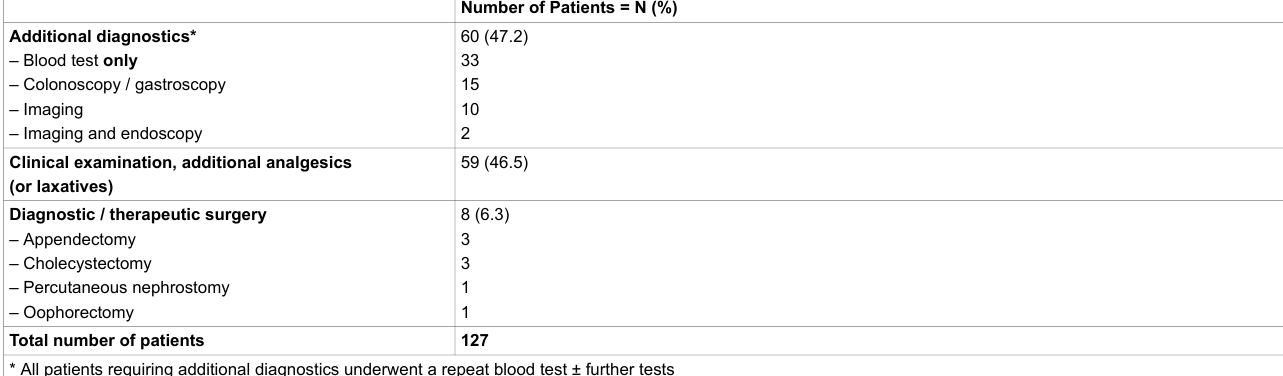
Table 3: Patients who consulted a GP, a specialist or a physician in our ED or in the ED of another hospital after initial discharge. Number of Patients = N (%)